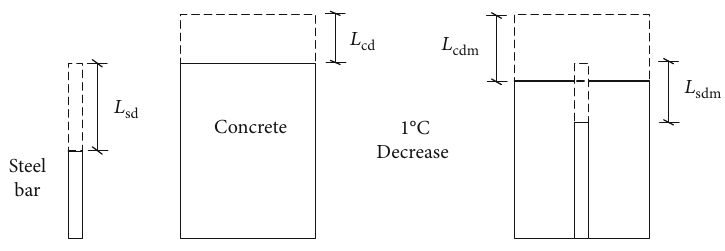
Figure 6: Changes in structure with decreasing